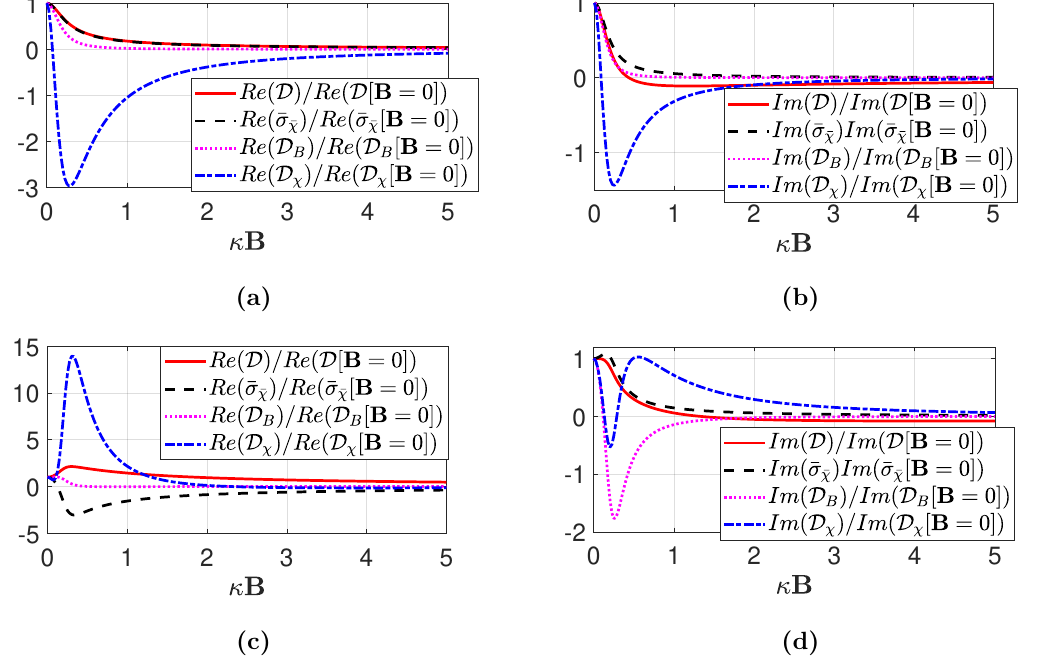
Figure 10. Real and imaginary parts of the TCFs as a function of (cid:20) B for (a), (b) ! = q 2 = 0 : 1 and (c), (d) ! = q 2 =